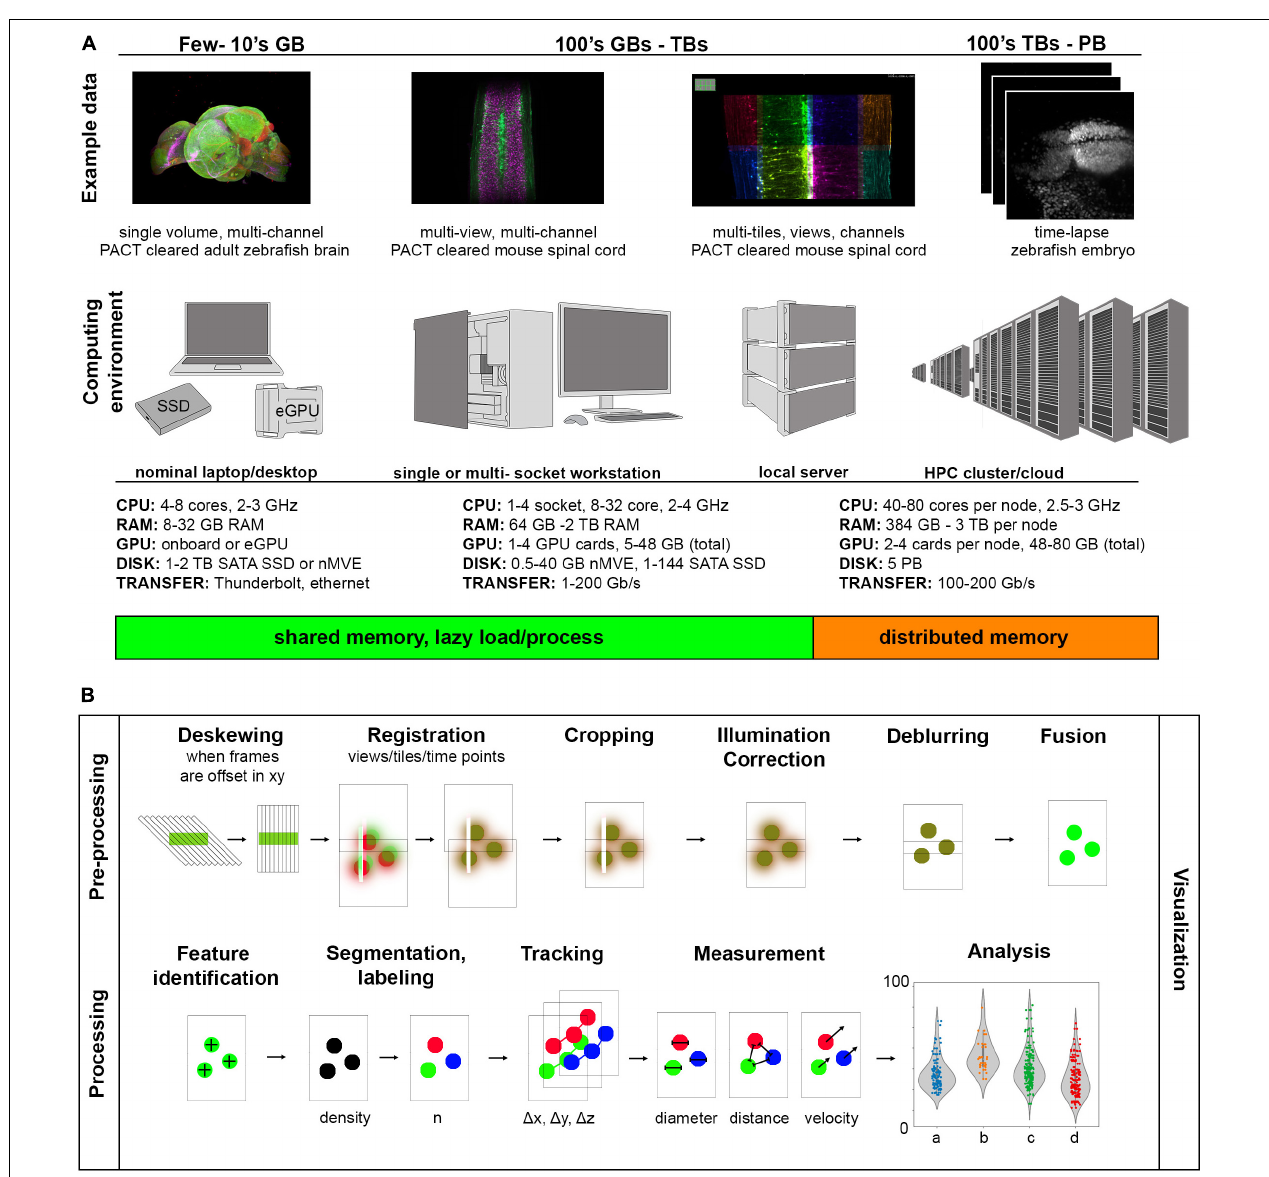
FIGURE 3 | Range of light-sheet data sizes, computing environments, and processing tasks. (A) As data size increases, increasingly parallel computation helps to prevent bottlenecking during image analysis. (B) Components of a light-sheet image analysis pipeline have highly variable pre-processing steps dependent on the particular type of light-sheet microscope used and more uniform processing steps depending on the biological measurement of